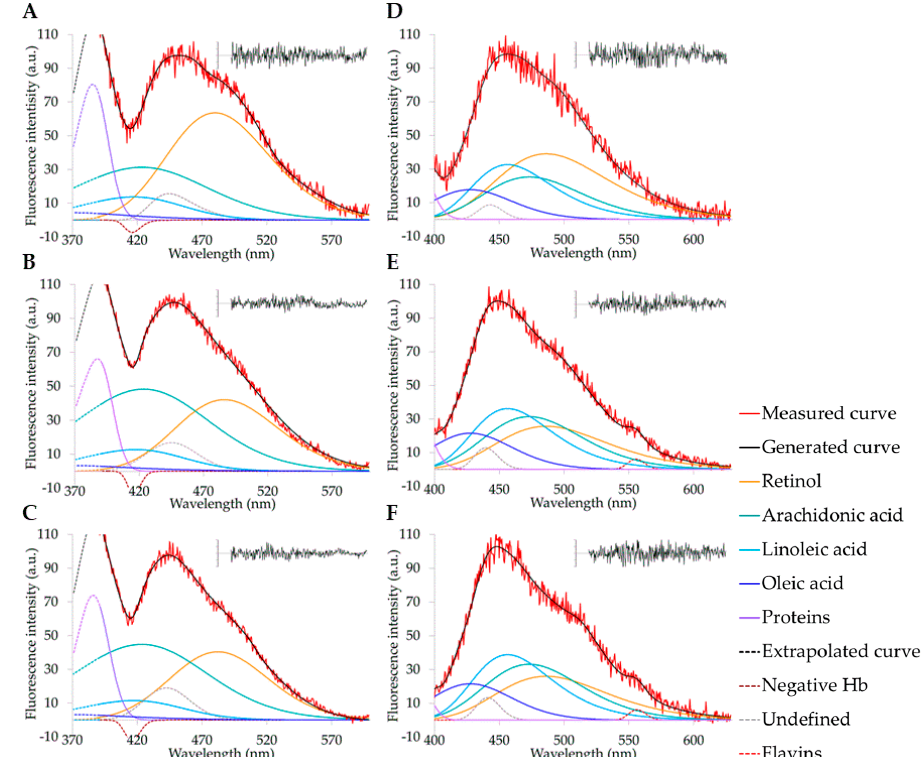
data relatable to linoleic acid for 310 nm excitation, AF data relatable to proteins for 366 nm excitation, and AF data of minor bands are not given because of values ≤ 5%.